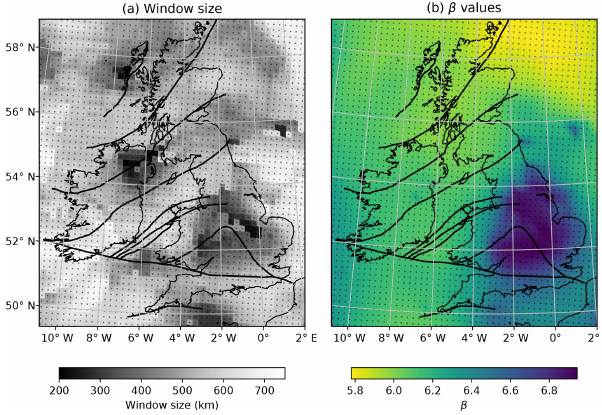
Figure 5. The ensemble of Curie depth estimates was computed across centroids spaced 20km × 20km apart, as indicated by black dots in each panel. (a) Combination of window sizes used to gener- ate the map of Curie depth (Fig. 6); each pixel illustrates the spatial resolution of our results; (b) maximum a posteriori distribution of β inverted from the magnetic anomaly and interpolated to the map resolution of 0.01 ◦